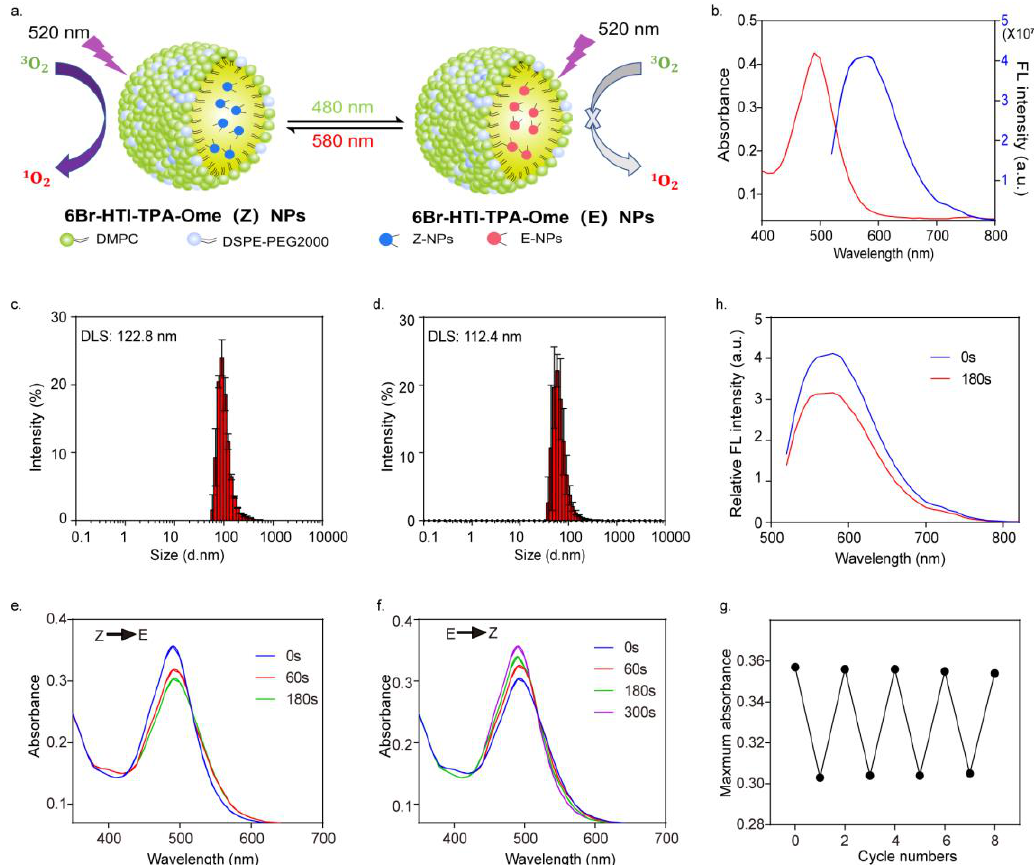
Figure 2. The photochromic behavior of 6Br-HTI-TPA-OMe NPs. ( a ) Schematic diagram of controllable 1 O 2 generation in Z-NPs and E-NPs; ( b ) the absorption (red line) and fluorescence (blue line) spectra of Z-NPs (10 µ M; Ex: 450 nm); dynamic light scattering (DLS) profiles of Z-NPs ( c ) and E-NPs ( d ); the absorption spectra changes of NP (25 µ M) upon alternating irradiation with 480 nm ( e ) and orange-red light at 580 nm ( f ); ( g ) the fatigue resistance of NPs for five cycles in water; ( h ) the fluorescence spectra change of NPs upon irradiation with 480 nm.